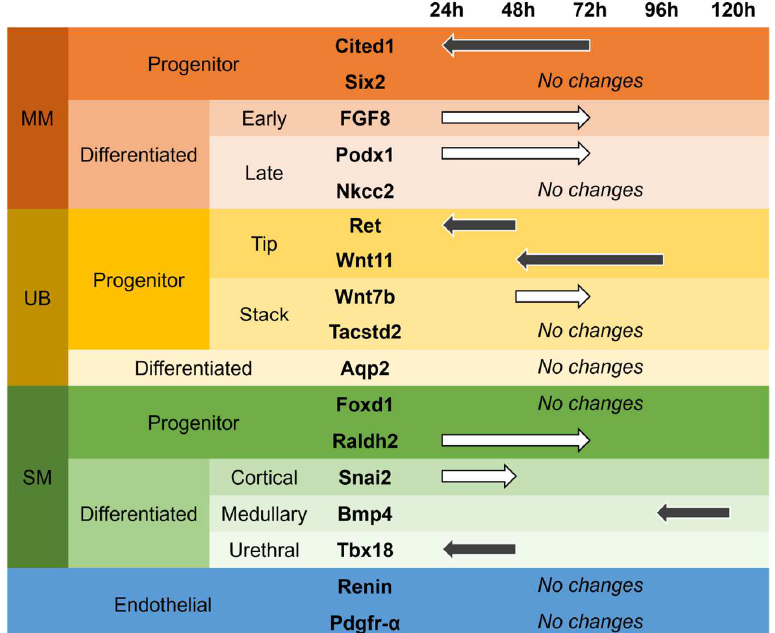
Figure 7. Chart of the expressional shift of developmental and the differentiation marker genes of the renal progenitor subpopulations in hypoxia vs. normal. Information is based on the qRT-PCR analysis above. Hypoxia causes UB tip branching markers Ret and Wnt11 to be expressed earlier, while a UB stalk marker Wntb7 is found delayed. MM differentiation marker FGF8 and Podx1 are delayed. Stroma progenitor cell marker Raldh2 is expressed later and the expression of stroma cell differentiation marker Snai2 is delayed, while stroma medullary marker Bmp4 and urethra marker Tbx18 are expressed earlier. Black arrow indicates an earlier gene expression in hypoxia compared to normoxia. White arrow indicates a later gene expression in hypoxia compared to